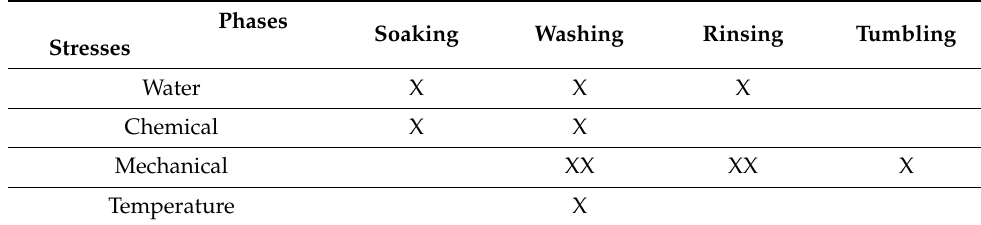
Table 1. Washing stresses [31]. (Reproduced with